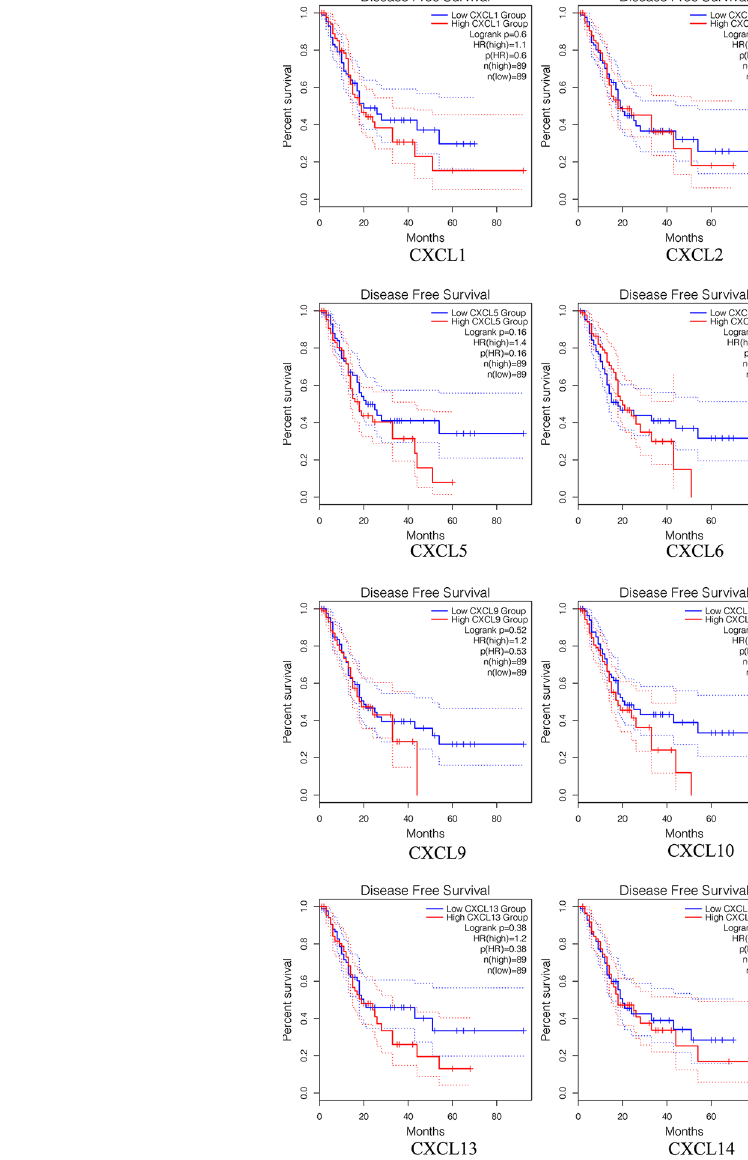
FIGURE 9 | The DFS of single CXC chemokine in patients with PAAD